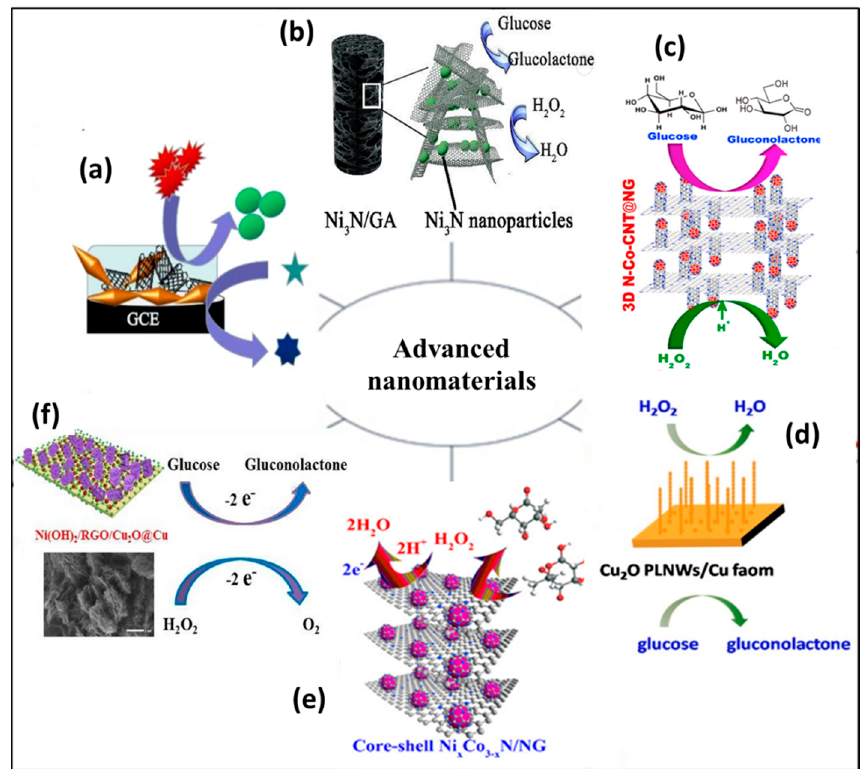
Figure 1. Schematic illustration of advanced nanomaterials for non-enzymatic electrochemical glucose and H 2 O 2 sensing: ( a ) AuNBP/MWCNT/GCE nanocomposites [35]; ( b ) Ni 3 N/GA samples ([36]); ( c ) 3D N-Co-CNT@NG ([37]); ( d ) Cu 2 O PLNWs/Cu foam ([38]); ( e ) core shell Ni x Co 3-x N/NG ([39]); ( f ) Ni (OH) 2 /RGO/Cu 2 O@Cu electrode ([40]).